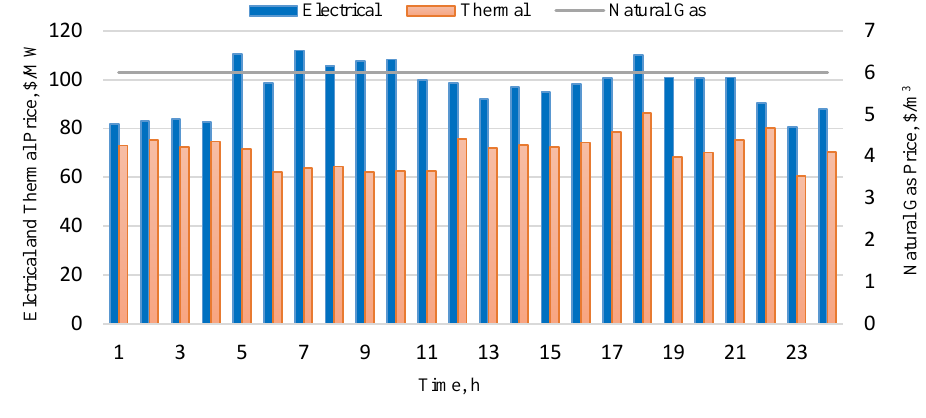
Fig. 5. Energy price in day ahead.